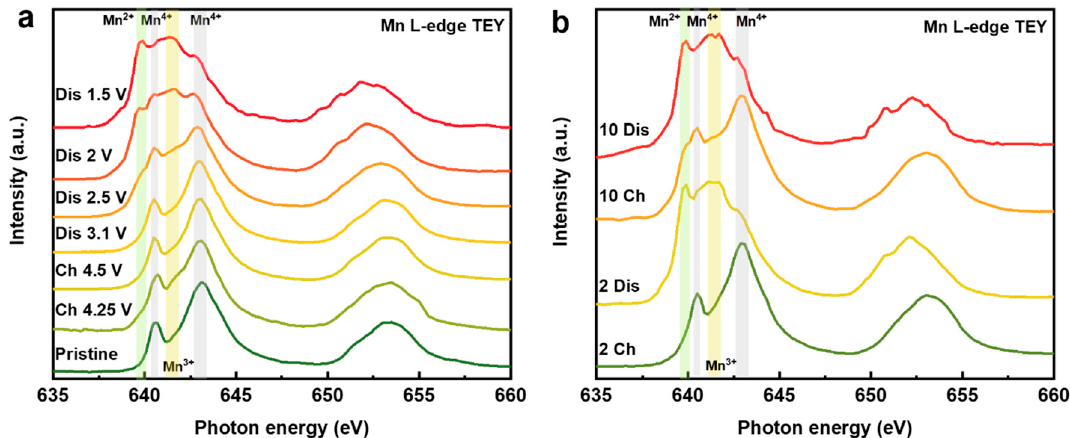
Figure 5. Mn L-edge sXAS (TEY mode) collected at different SOCs of the initial cycle ( a ) and at fully charged and discharged states after 2 and 10 cycles ( b ).